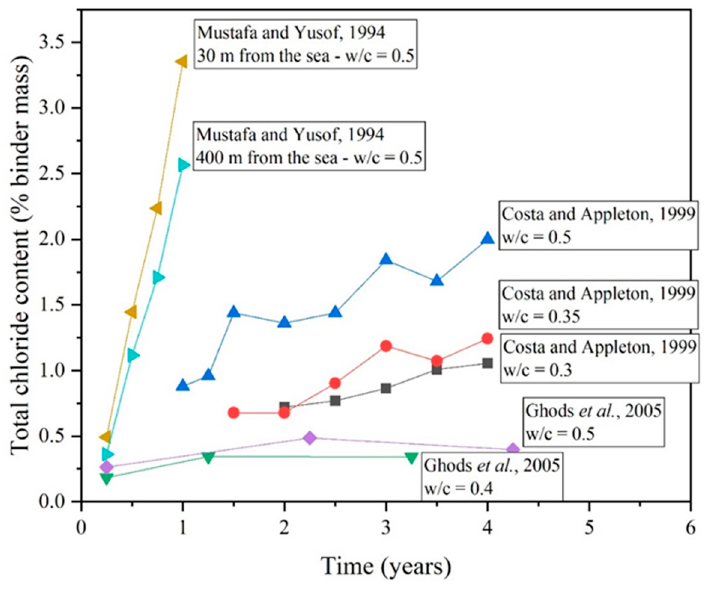
Figure 1. Relationship between surface chloride content in concrete and exposure time [3,6,7].